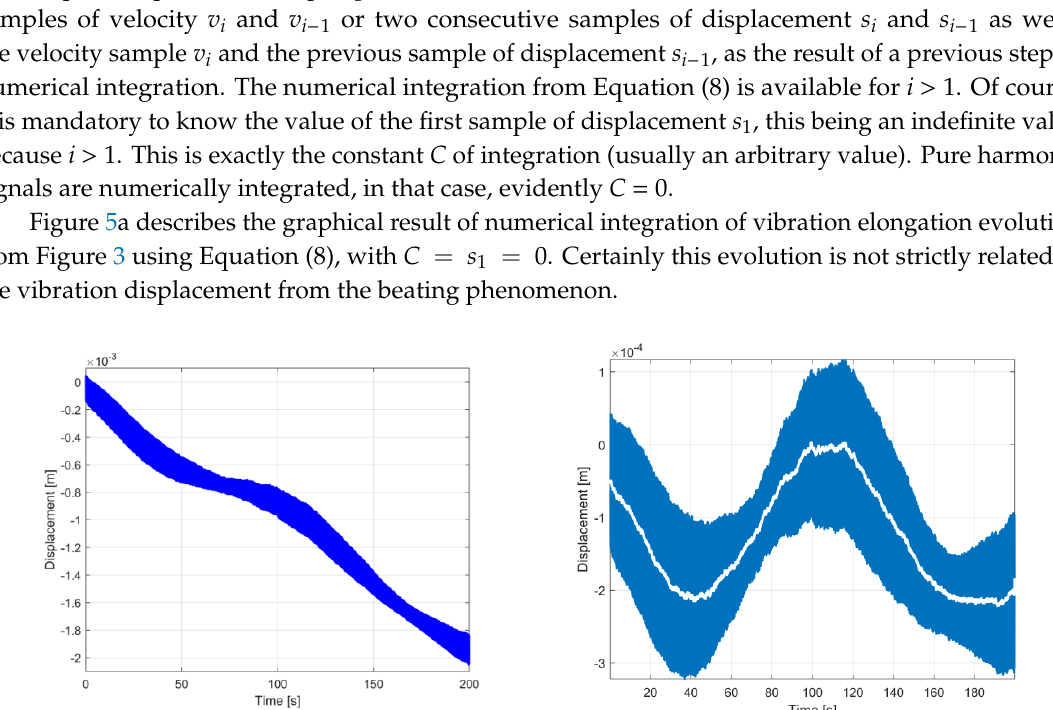
Figure 6. The result of the numerical derivative of the evolution from Figure 5b (vibration velocity, practically similar with Figure 3).